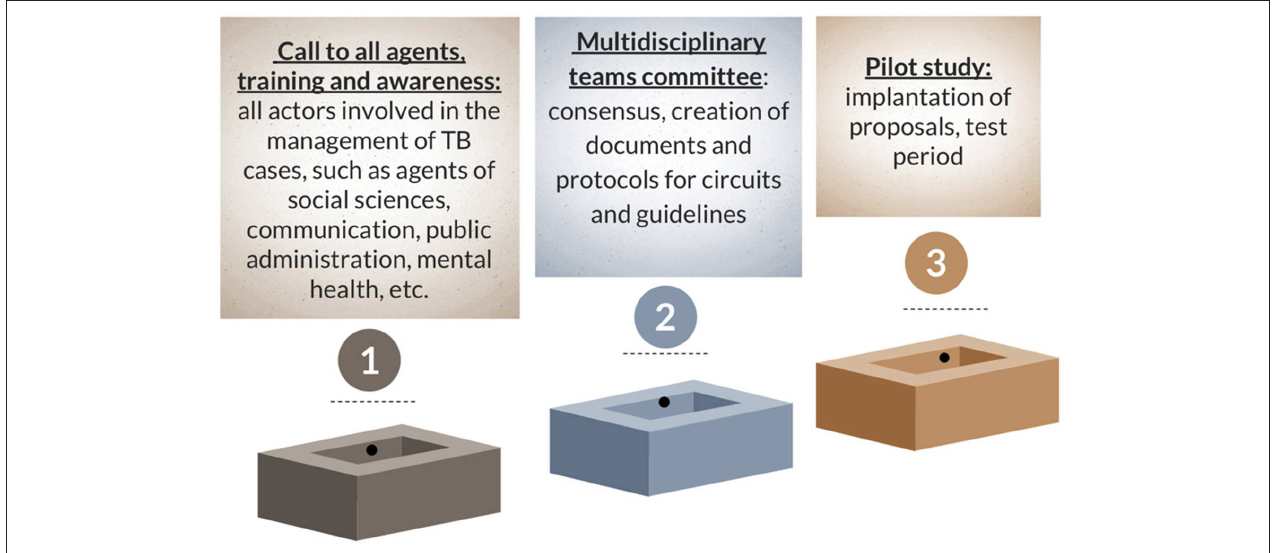
FIGURE 2 | Creation of interdisciplinary teams: